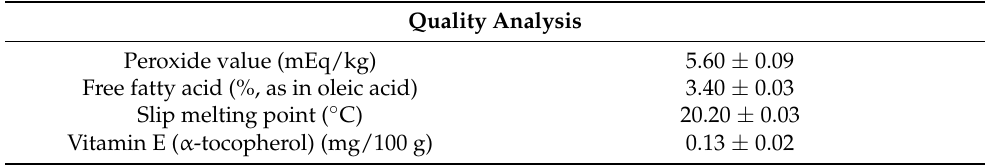
Table 2. Peroxide value, free fatty acid, slip melting point and vitamin E in